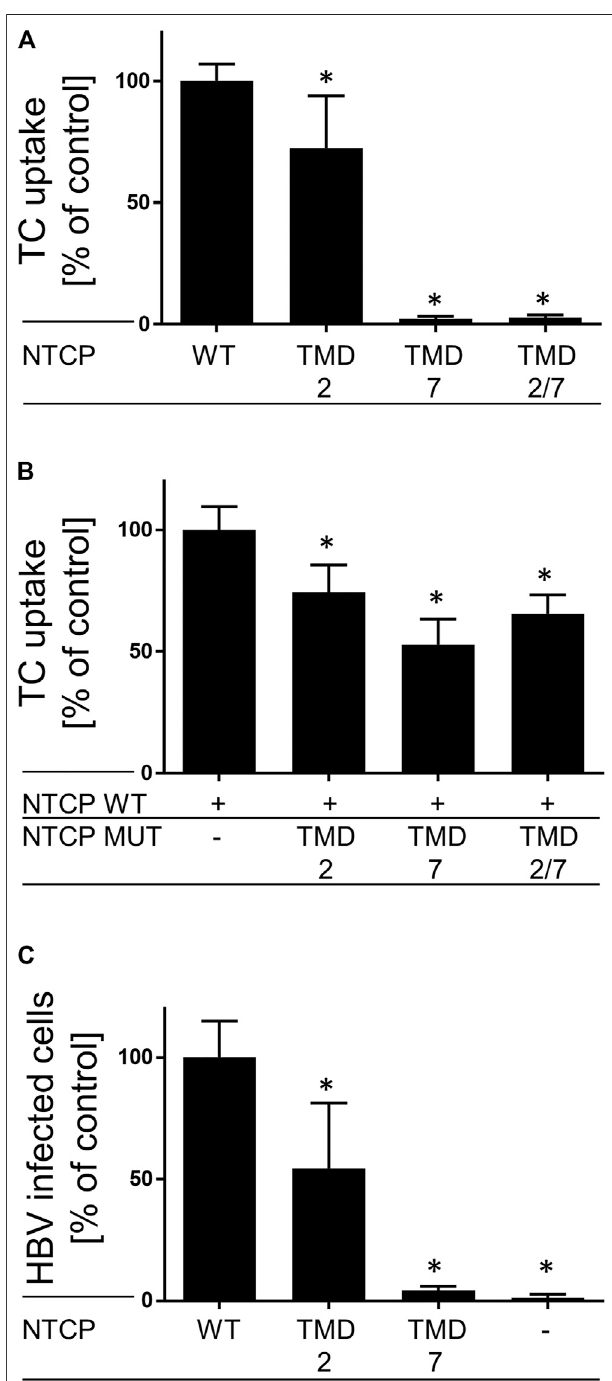
FIGURE 4 | Bile acid transporter and HBV receptor functions of NTCP mutants. The indicated wild-type and mutant NTCP constructs were (A) mono- or (B) double-transfected into HEK293 cells as indicated. At 48 h post transfection, cells were incubated for 10 min with 10 µM [ 3 H]TC and transport rates were determined compared to wild-type NTCP (set to 100%). Data represent means ± SD of combined data of two independently performed experiments with triplicate determinations. (C) HepG2 cells were transiently transfected with the wild-type and mutant NTCP constructs,